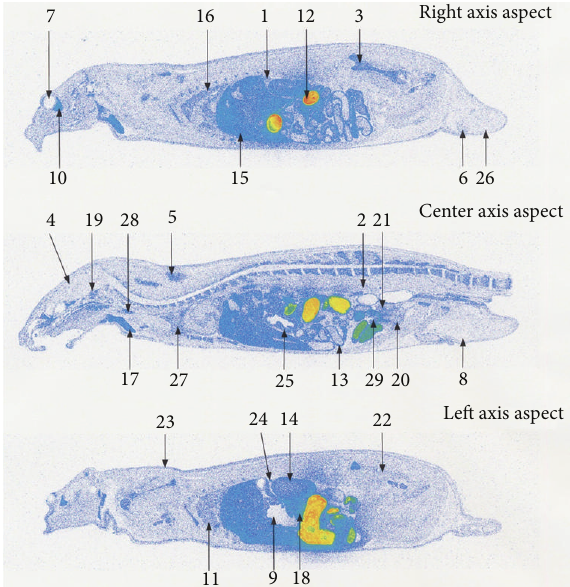
Figure 2: Whole body radioluminograms 8 hours after single oral administration of 14 C hyaluronic acid to a rat (dose: 25 mg/kg). (1) Adrenal gland. (2) Blood. (3) Bone marrow. (4) Brain. (5) Brown fat. (6) Epididymis. (7) Eyeball. (8) Fat. (9) Gastric contents. (10) Harderian gland. (11) Heart. (12) Intestinal contents. (13) Intestine. (14) Kidney. (15) Liver. (16) Lung. (17) Mandibular gland. (18) Pancreas. (19) Pituitary gland. (20) Prostate gland. (21) Seminal vesicle. (22) Skeletal muscle. (23) Skin. (24) Spleen. (25)